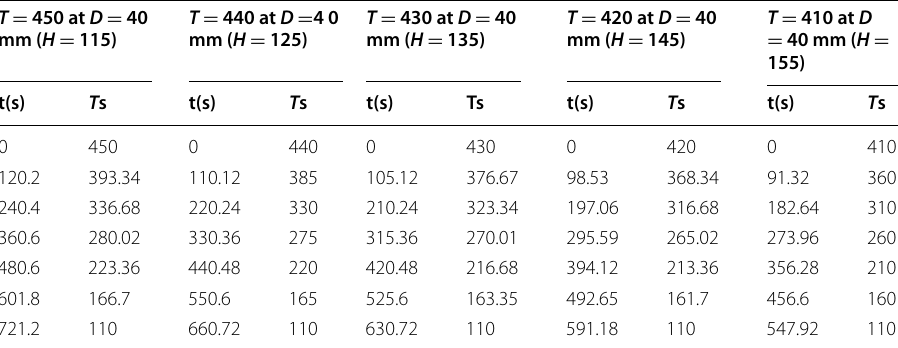
40 mm variant T and H for A-JIC = 40 =